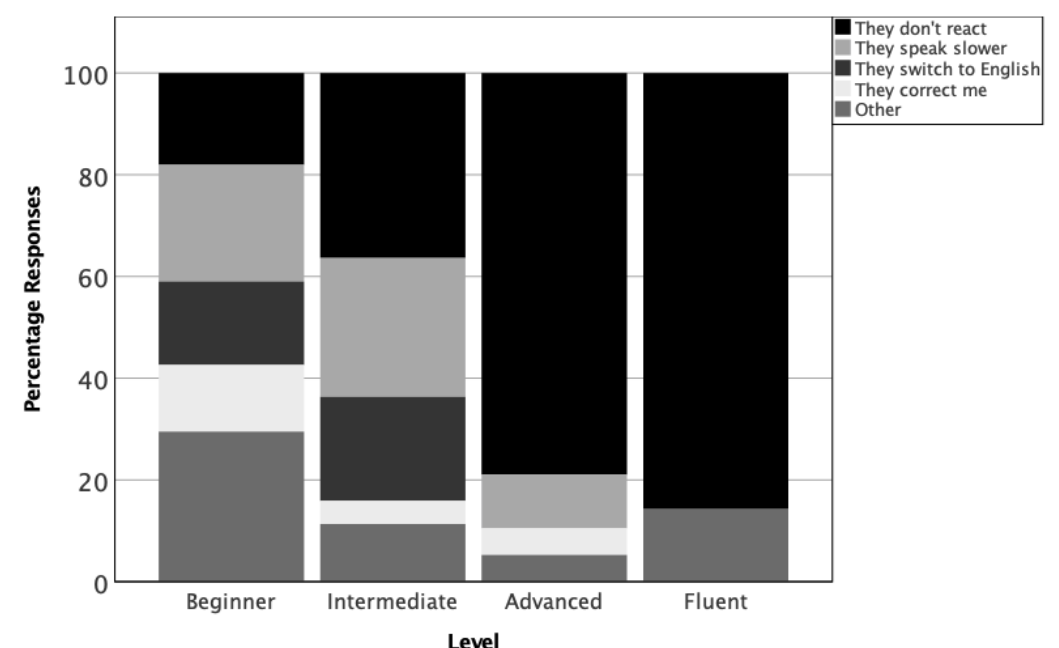
Figure 5. Proportion of responses per level for “How do ‘native’ speakers react to your accent/pronunciation”? Beginner n = 52; Intermediate n = 38; Advanced n = 18; Fluent n = 7.